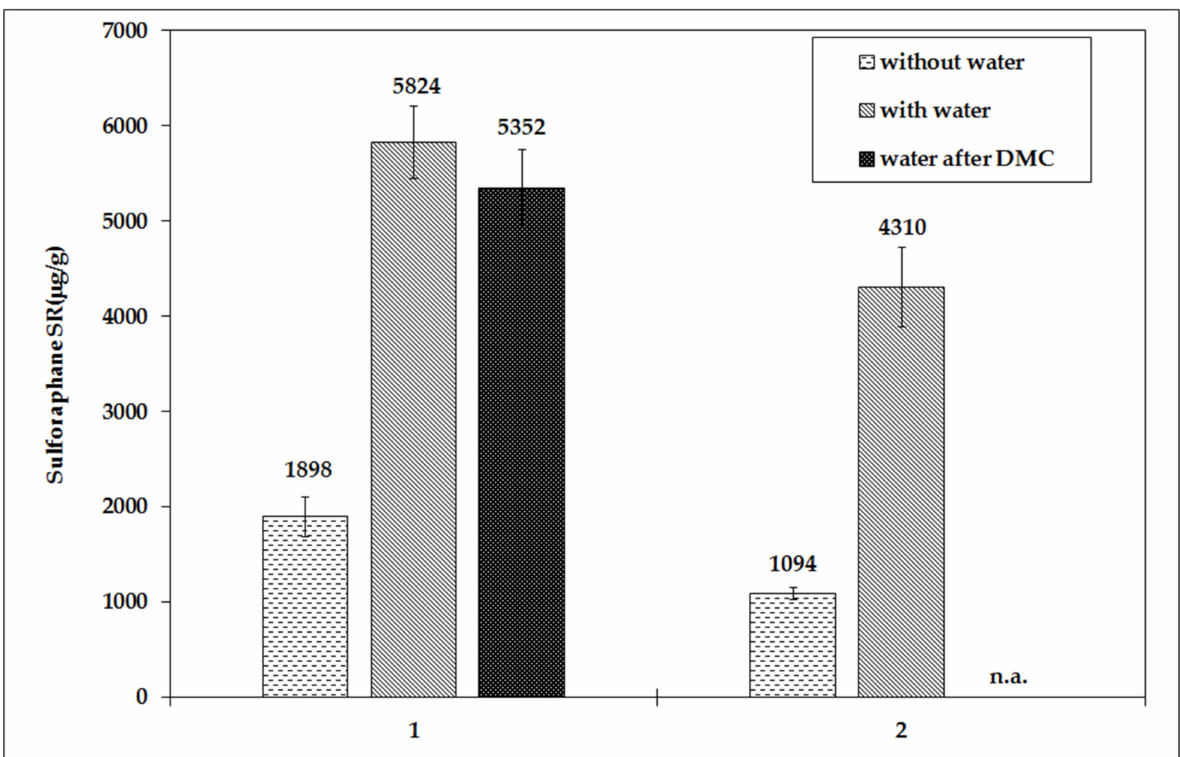
Figure 3. Influence of the sample preparation method on SR analysis using HPLC for lyophilized mixtures (OPHT)—Batch 1 on the left and Batch 2 on the